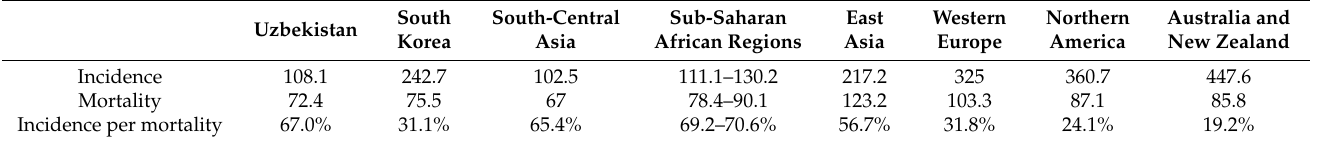
Table 1. Brief global statics of cancer, including Uzbekistan and South Korea.